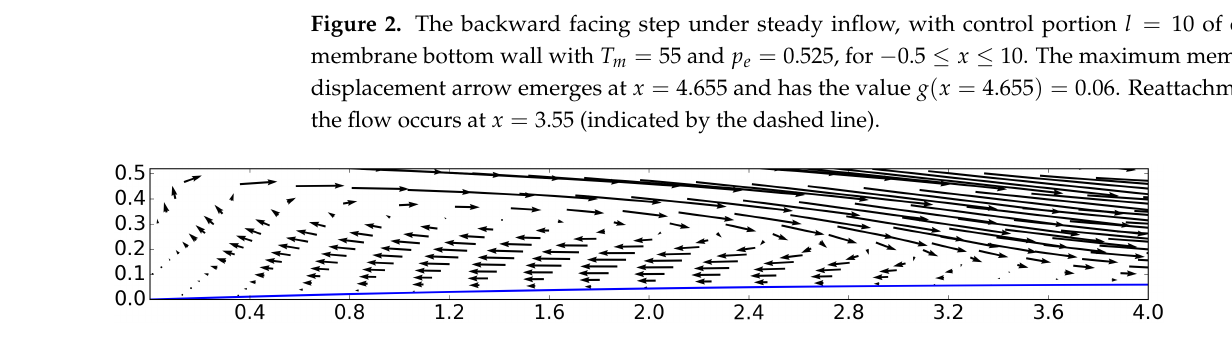
Figure 3. Backward facing step under steady inflow, with control portion l = 10 of elastic membrane bottom wall with T m = 55 and p e = 0.525. Detail of the lower wall recirculation region for 0 ≤ x ≤ 4 and 0 ≤ y ≤ 0.5.